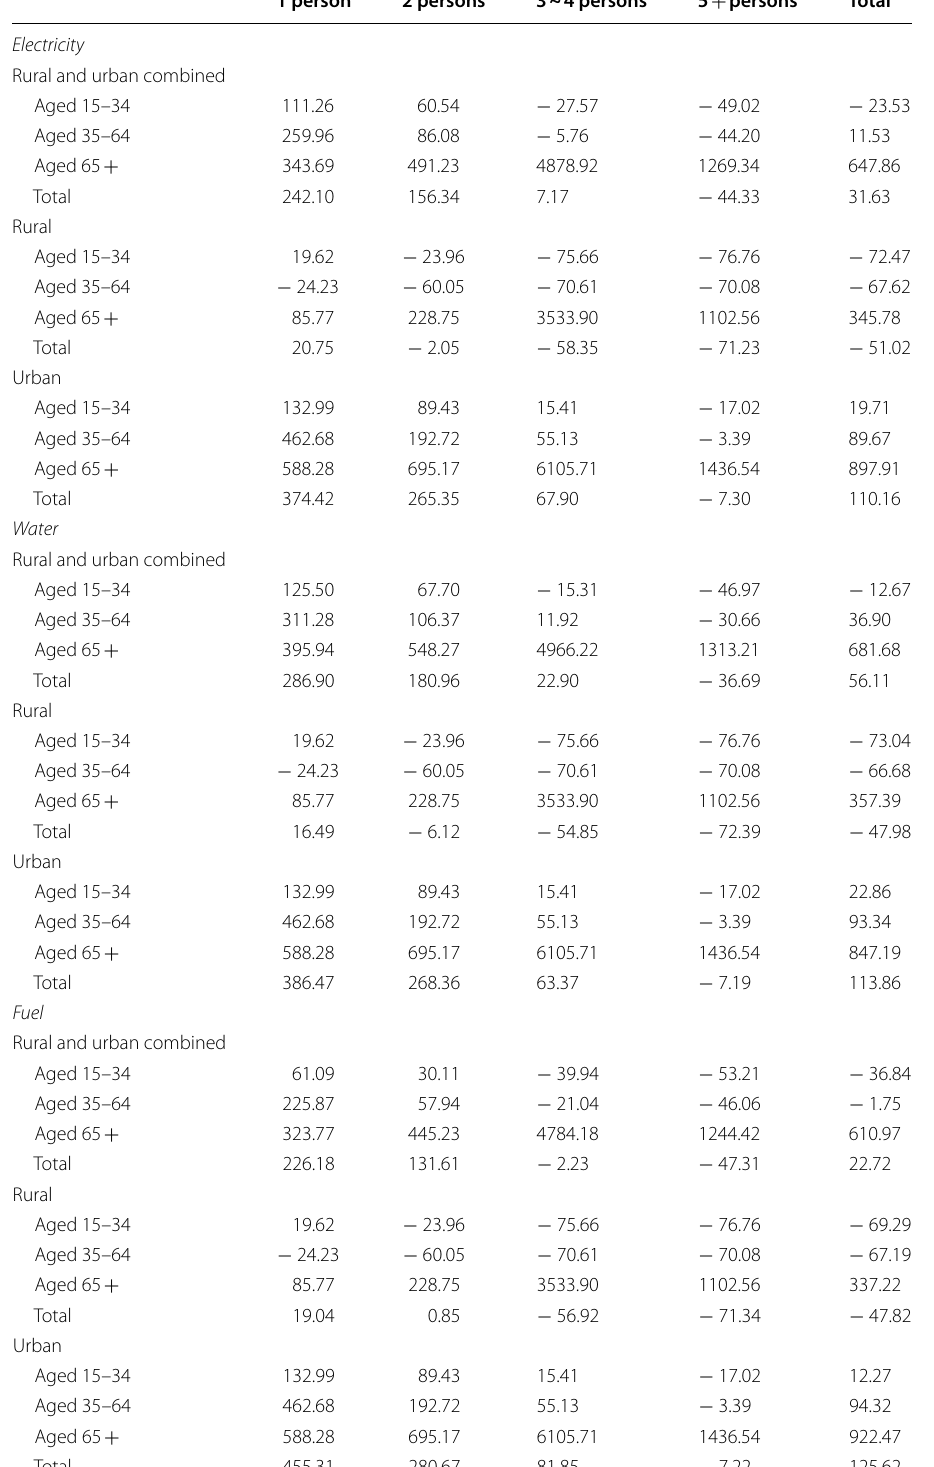
Table 3 Relative % increase of residential energy demands in 2050 as compared with 2010 by rural/ urban, household size and ages of householder, Hebei province,